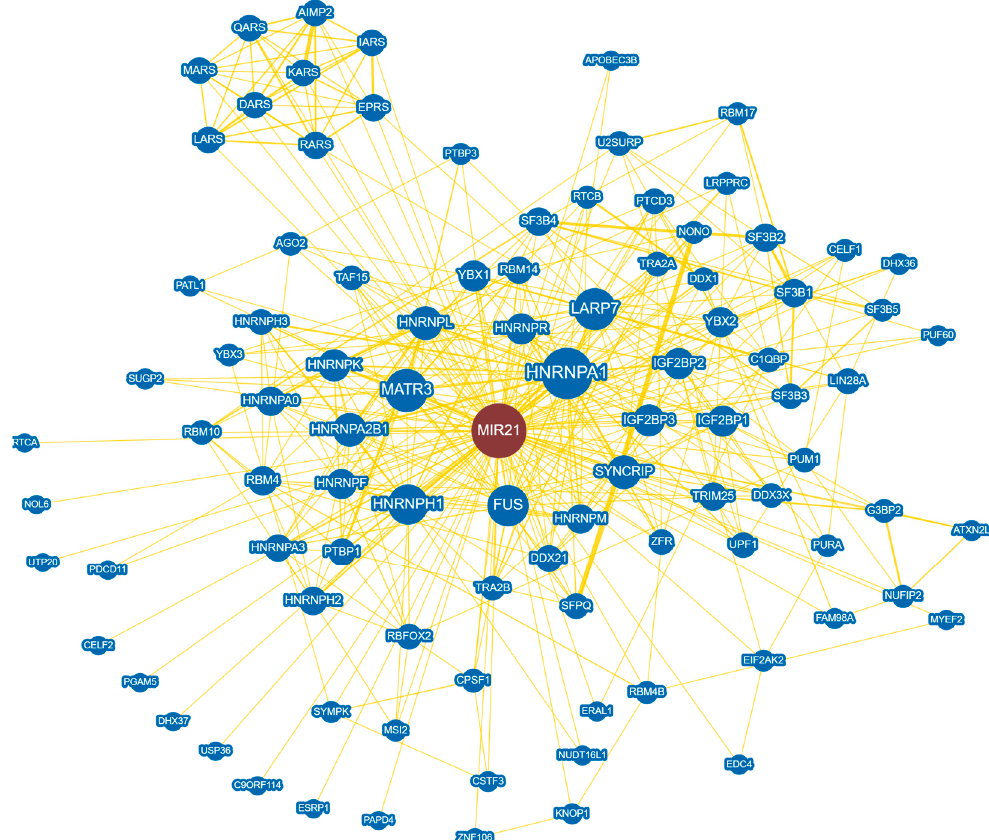
Figure 4. BioGRID protein interaction analysis of hsa-miR-21 interactome. In total, 96 protein interactions are displayed with an arbor layout in which related nodes are spaced closer together. Of the 96 protein interactors, 94 were found through high-throughput evidence, while 2 were found through low-throughput. AGO2—argonaute RISC catalytic component